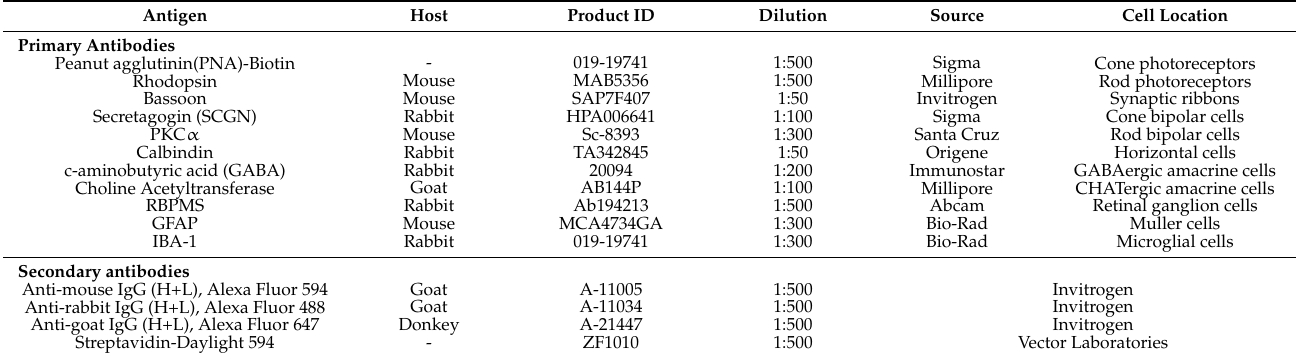
Table A1. Primary and secondary antibodies used in immunofluorescence study.